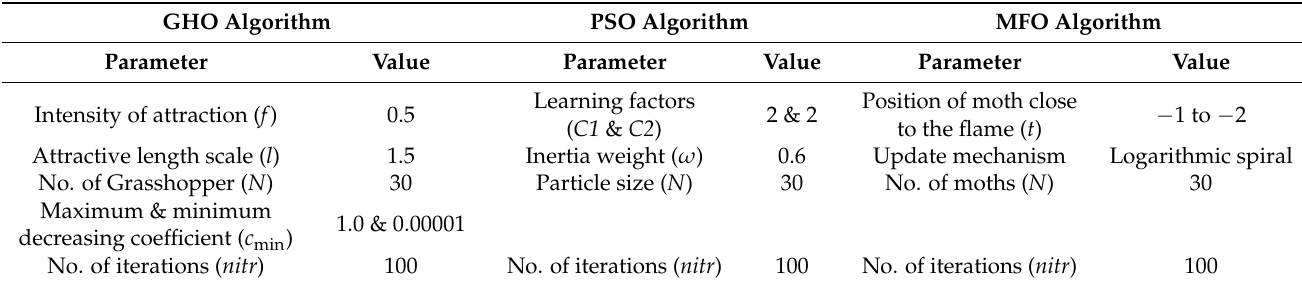
Table 9. Parameters and its values used in GHO, PSO, and MFO algorithms.